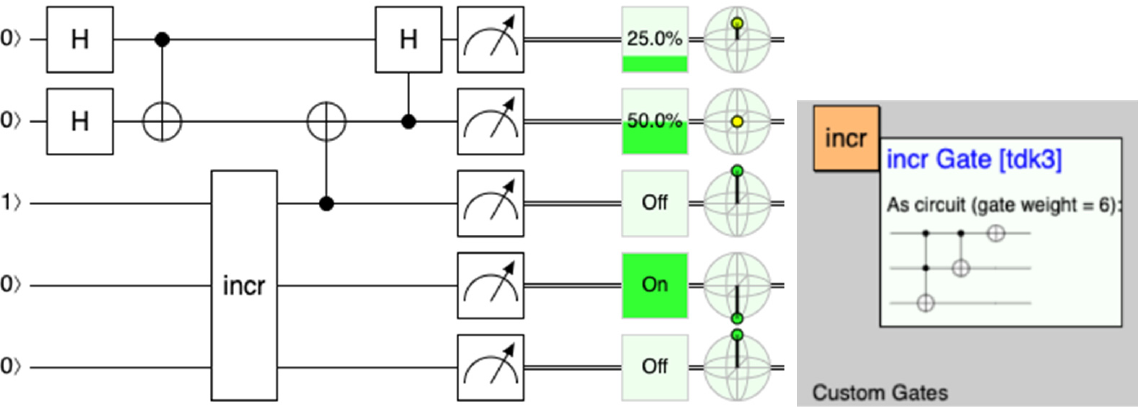
Figure 9. Circuit including the reuse of a module (called “incr” and detailed on the right side) with functional cohesion (image obtained using the https://algassert.com tool, accessed on 23 June 2021).